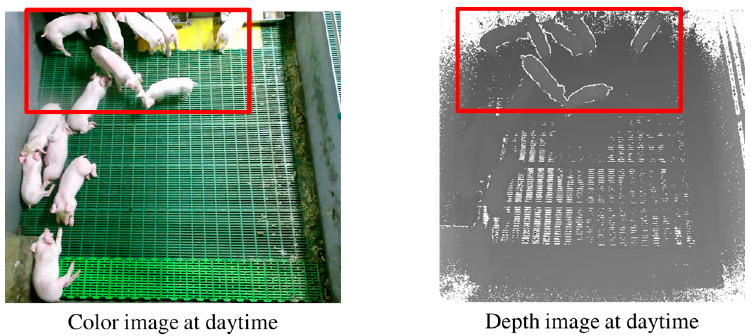
Figure 6. Standing-pigs within the bold box have undefined outlines.